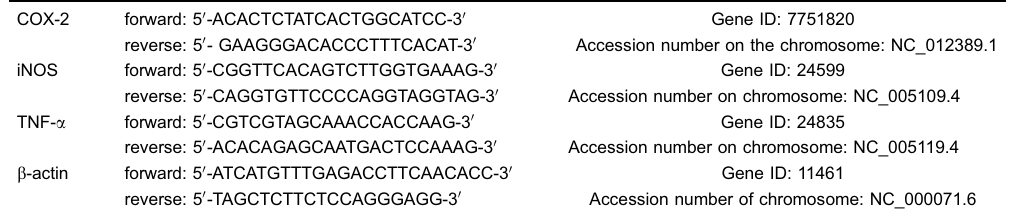
Table 1. Sequences of forward and reverse